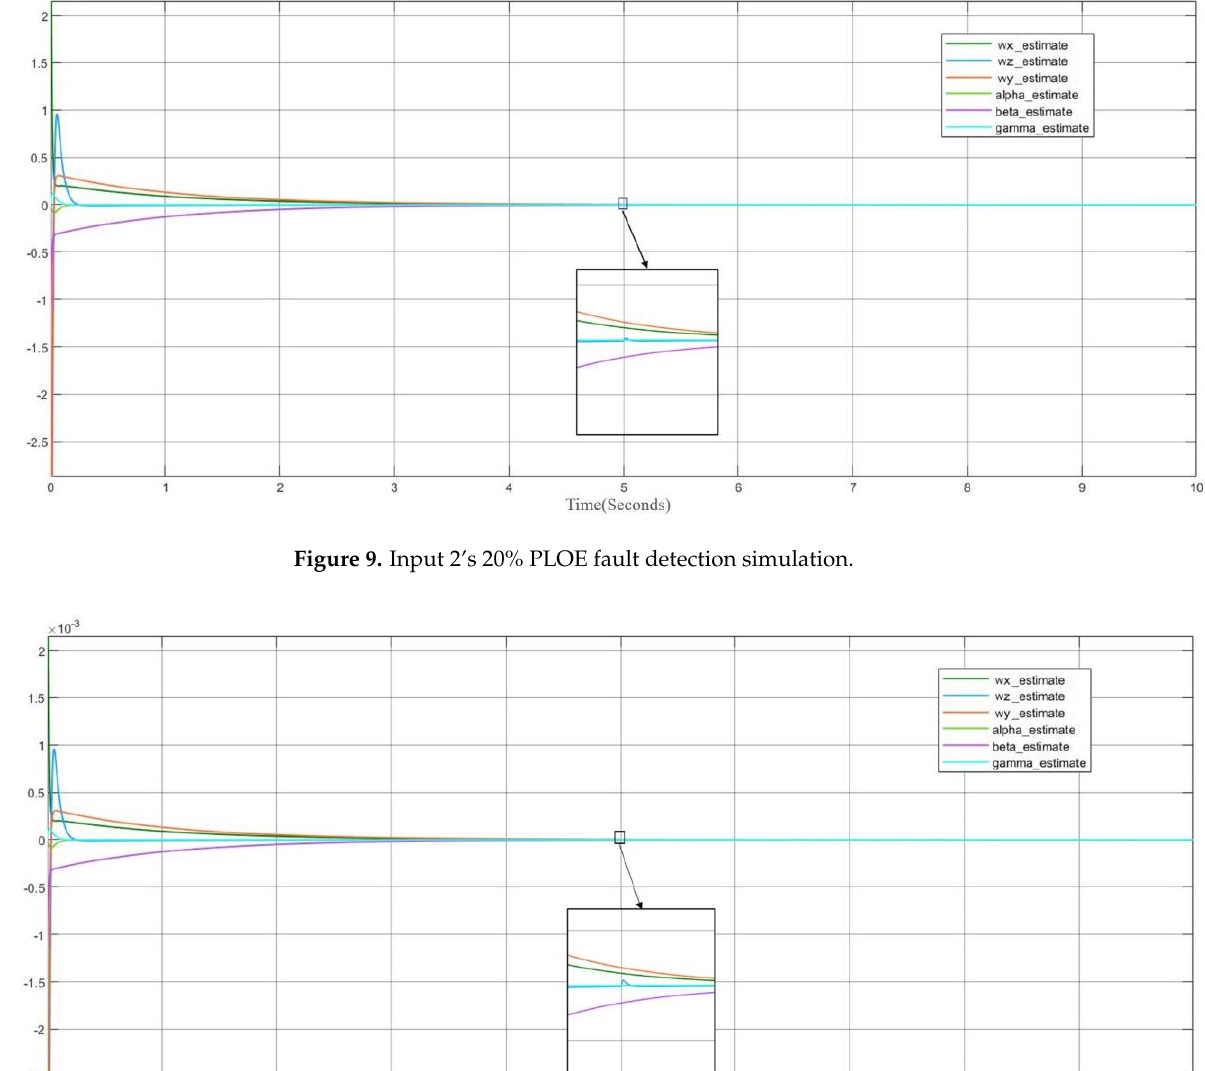
Figure 11. Input 2’s 60% PLOE fault detection simulation.